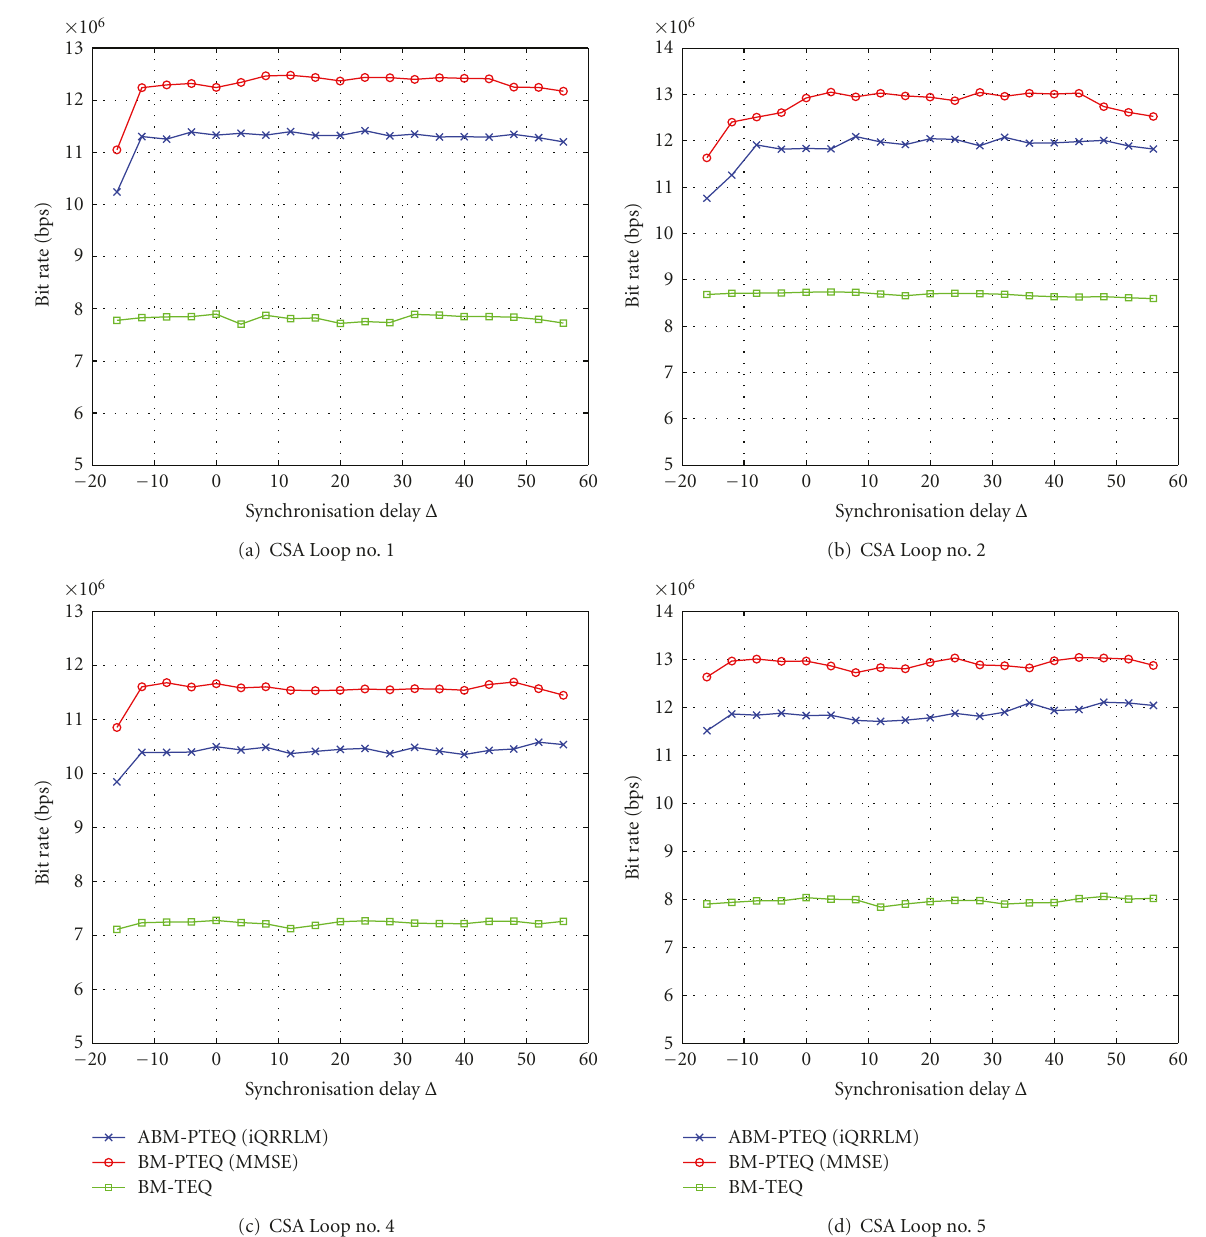
Figure 2: Bit rate as a function of the synchronisation delay Δ for ADSL downstream starting at tones 38 to 255, when the samples of CSA loop are (a) CSA Loop no. 1, (b) CSA Loop no. 2, (c) CSA Loop no. 4, and (d) CSA Loop no.